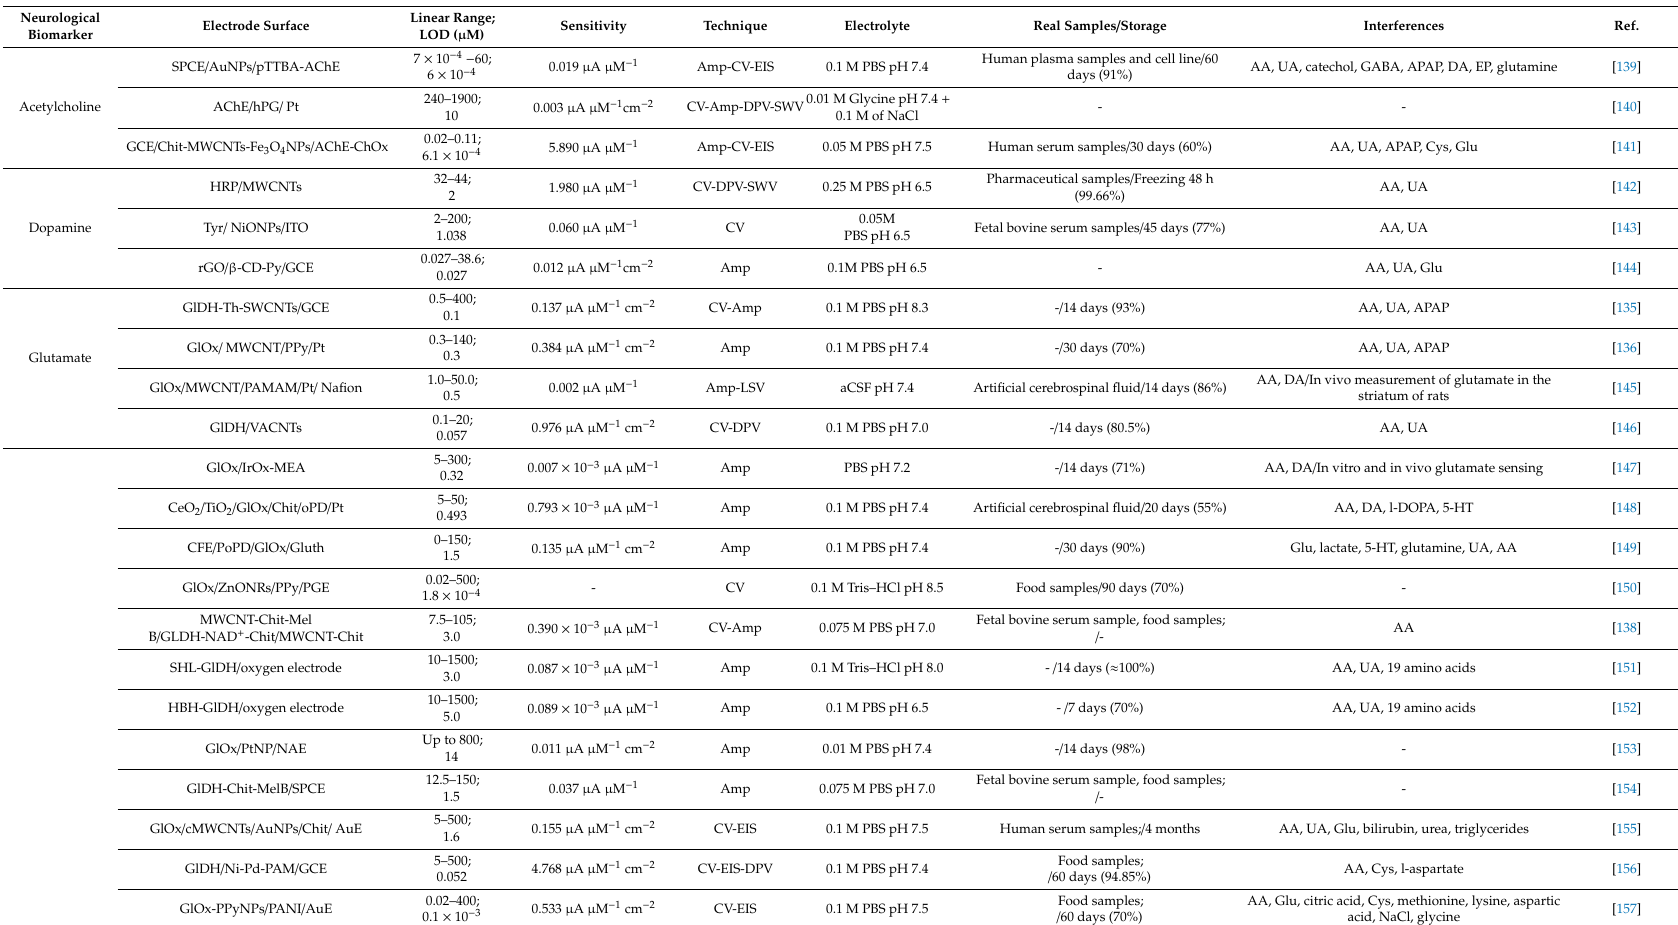
Table 3. Enzymatic biosensors for neurological biomarkers